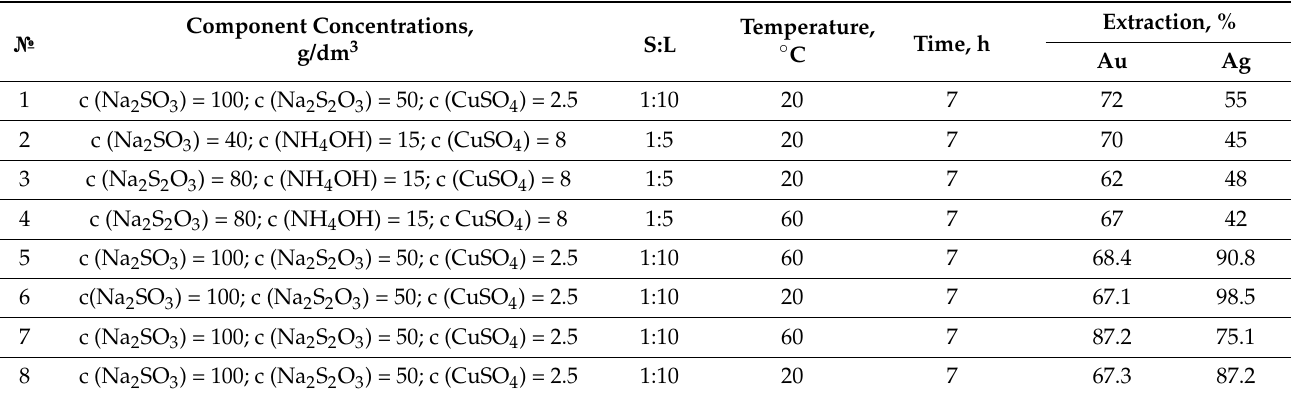
Table 6. Leaching process results for residue after thermochemical activation with complex reagents based on sulfur